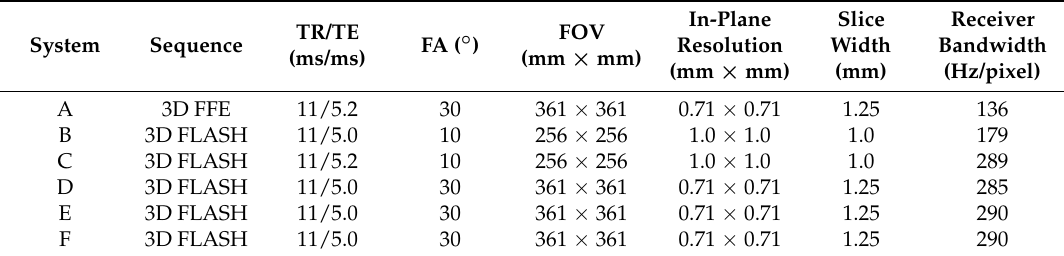
Table 2. Imaging parameters for each of the six scanners employed in this study (FA = flip angle, TR = repetition time; TE = echo time, FOV =